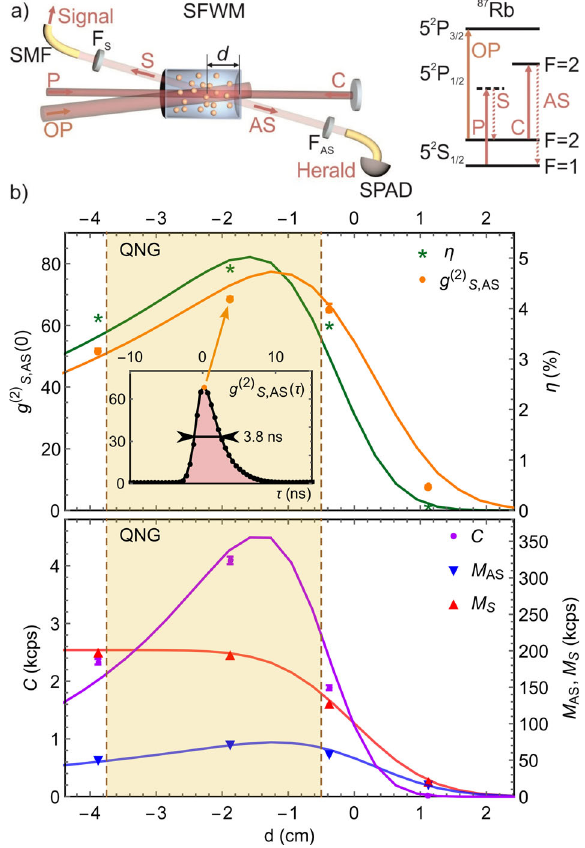
Fig. 1 Scheme of the SFWM source and basic characteristics of generated biphotons. a shows a simpli fi ed excitation geometry realized with a single laser frequency with counter-propagating collimated pump (P) and coupling (C) beams. Distance d is de fi ned between the center of the intersection of excitation and observation spatial modes and the cell output viewport along the pump beam propagation direction. The optical pumping (OP) beam effectively covers the interaction area. The Stokes (S) and anti-Stokes (AS) fi elds are selected by a combination of Fabry – Pérot cavities, Glan – Thompson polarizers, and optical cut-off fi lters, marked together as F S and F AS , respectively. Spatial modes are set by the coupling into single-mode fi bers (SMF) in two opposite directions. The energy level scheme of 87 Rb depicts the SFWM process corresponding to the emission of off-resonant Stokes and near- resonant anti-Stokes fi elds for the excitation laser set close to the 5S 1/2 (F = 2) ↔ 5P 1/2 (F = 2) transition. The graphs in ( b ) show basic characteristics of generated biphotons including two-photon coupling ef fi ciency η 2ph and maxima of the intensity correlation ð 0 Þ between single-photon avalanche diodes (SPAD) in function g ð 2 Þ S ; AS the heralding — anti-Stokes and in the signal — Stokes channels. The ð τ Þ . Stokes M inset shows an example of g 2 S , anti-Stokes M AS , and S ; AS coincidence C photodetection rates in kilo-counts/s are shown as red, blue, and magenta data points, respectively. For comparison, QNG marks an area of expectable observability of QNG features. Error bars correspond to a single standard deviation and, where not illustrated, their size is smaller than the size of the corresponding plot